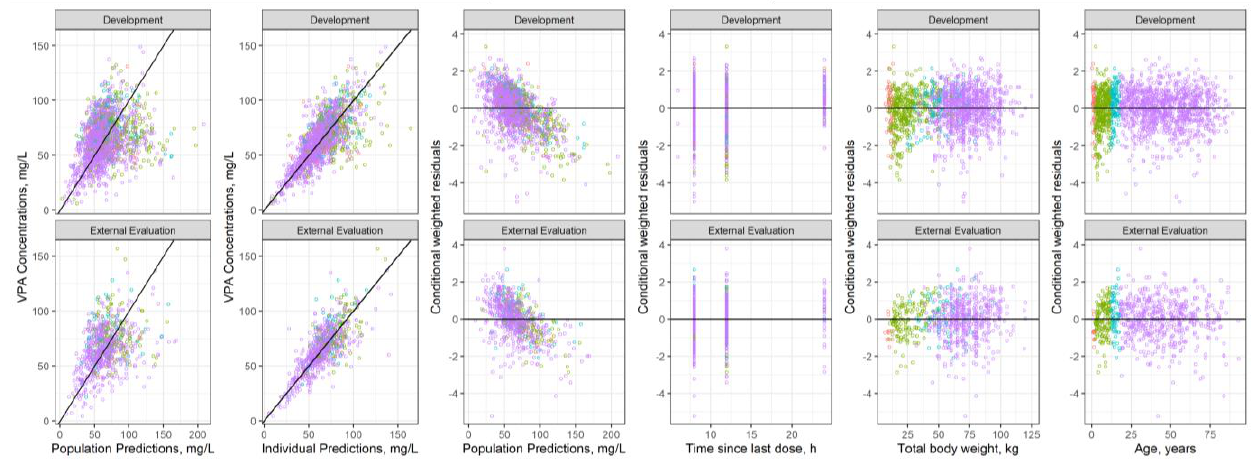
Figure 1. Goodness-of-fit plots for the development dataset (upper panels) and the external evaluation dataset (lower panels) colored by age classification (AGEC), • 28 d–2 y • 2–11 y • 12–18 y • >18 y. The covariates fulfilling the statistical requirement for inclusion ( p < 0.001)